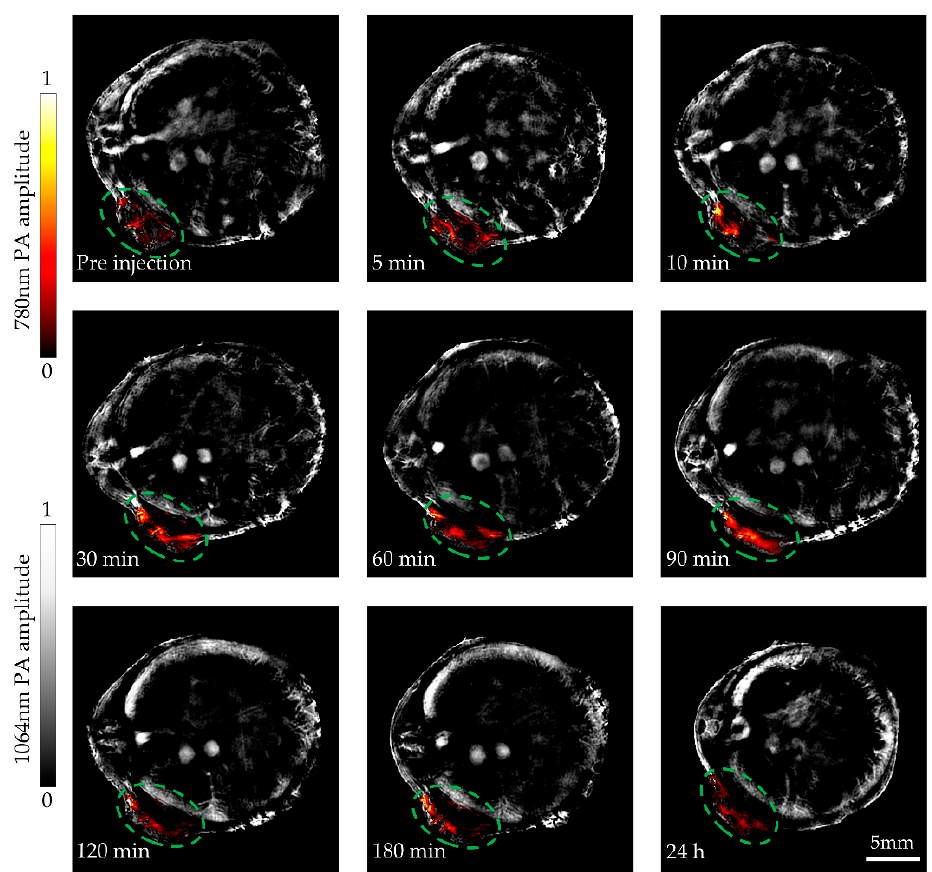
Figure 8. ICG-Lips accumulation in tumors for 24 h was monitored by our PACT system. The PA images of mouse tissues imaged by a 1064 nm wavelength laser are shown in gray. The PA images of ICG-Lips in tumors imaged by a 780 nm wavelength laser are shown in color.